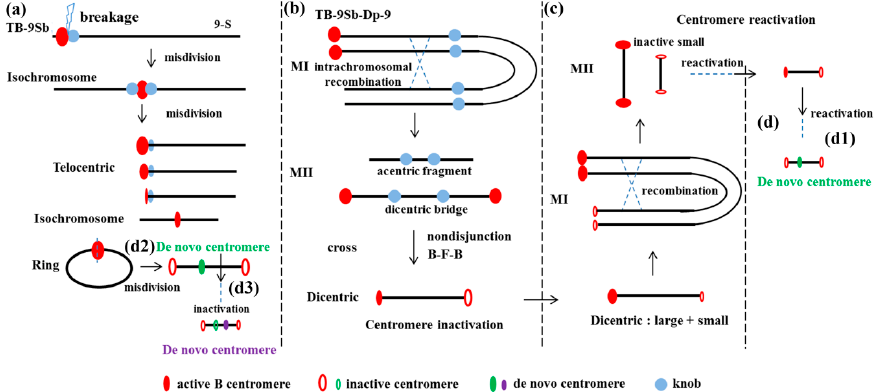
Figure 2. Diagrams of centromere behavior associated with the B chromosome. ( a ) The first misdivision process of a TB-9Sb chromosome produced a pseudoisochromosome; and different types of B chromosome variants formed, including telocentric chromosomes, ring chromosomes, and isochromosomes. ( b ) The TB-9Sb-Dp9 chromosome underwent intrachromosomal recombination